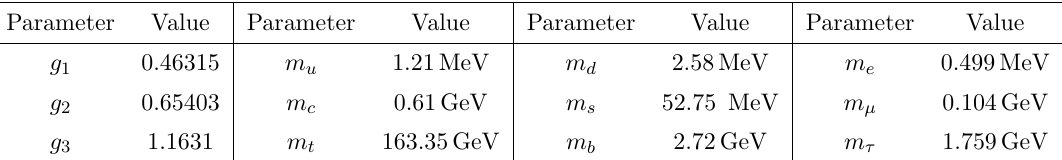
t = 173 : 1 GeV in MS scheme. See for